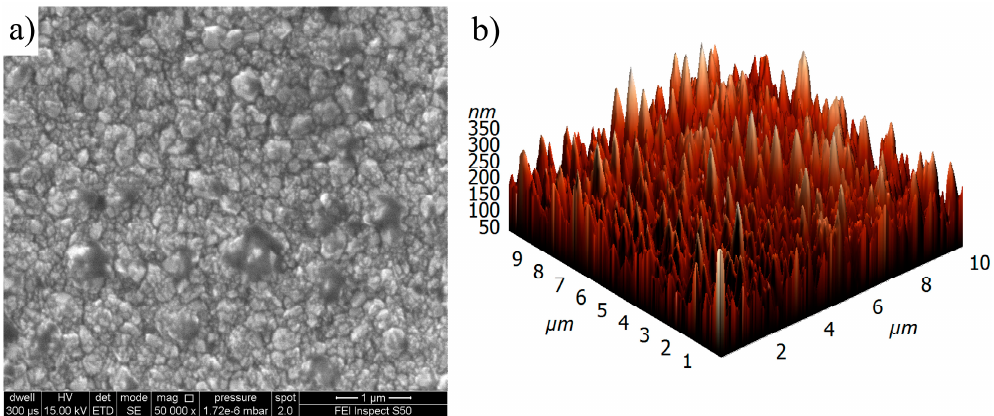
Figure 2. The surface topography of diamond film: ( a ) SEM image; ( b ) atomic force microscopy (AFM) image.